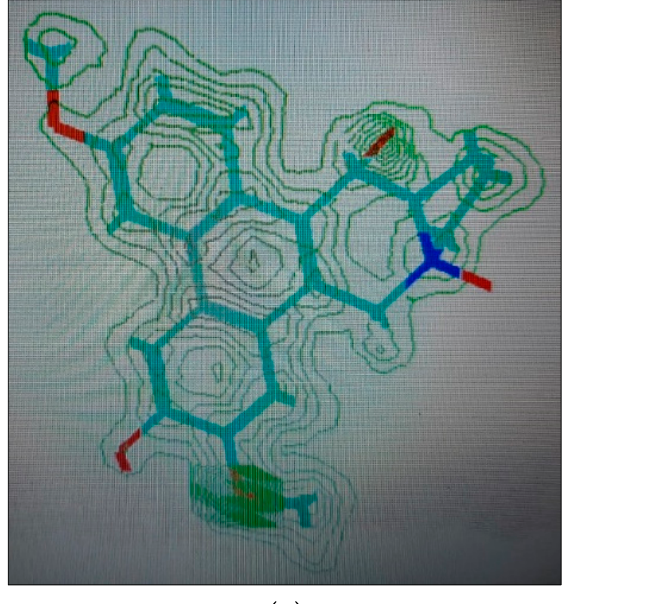
Figure 8. Structure ( 5 ) (tylophorinidine), 2D renderings: ( a ) charge density localizations; ( b ) electrostatic potential.